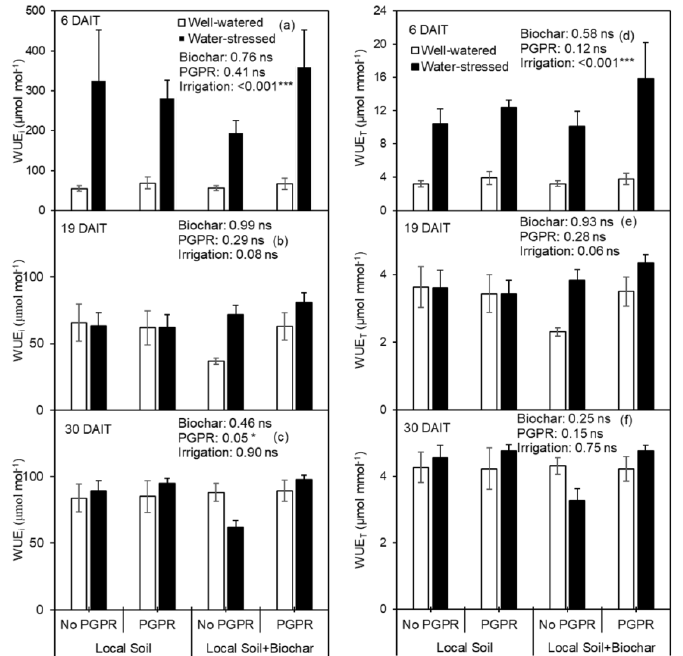
Figure 6. ( a – c ) Intrinsic water use efficiency (WUE i ) and ( d – f ) instantaneous water use efficiency (WUE T ) of potato leaf as affected by biochar amendment and PGPR inoculation after DI exposed. * and *** indicate significance effect at p < 0.05 and p < 0.001 level, respectively, and ns indicates the effect was not statistically significant at p < 0.05